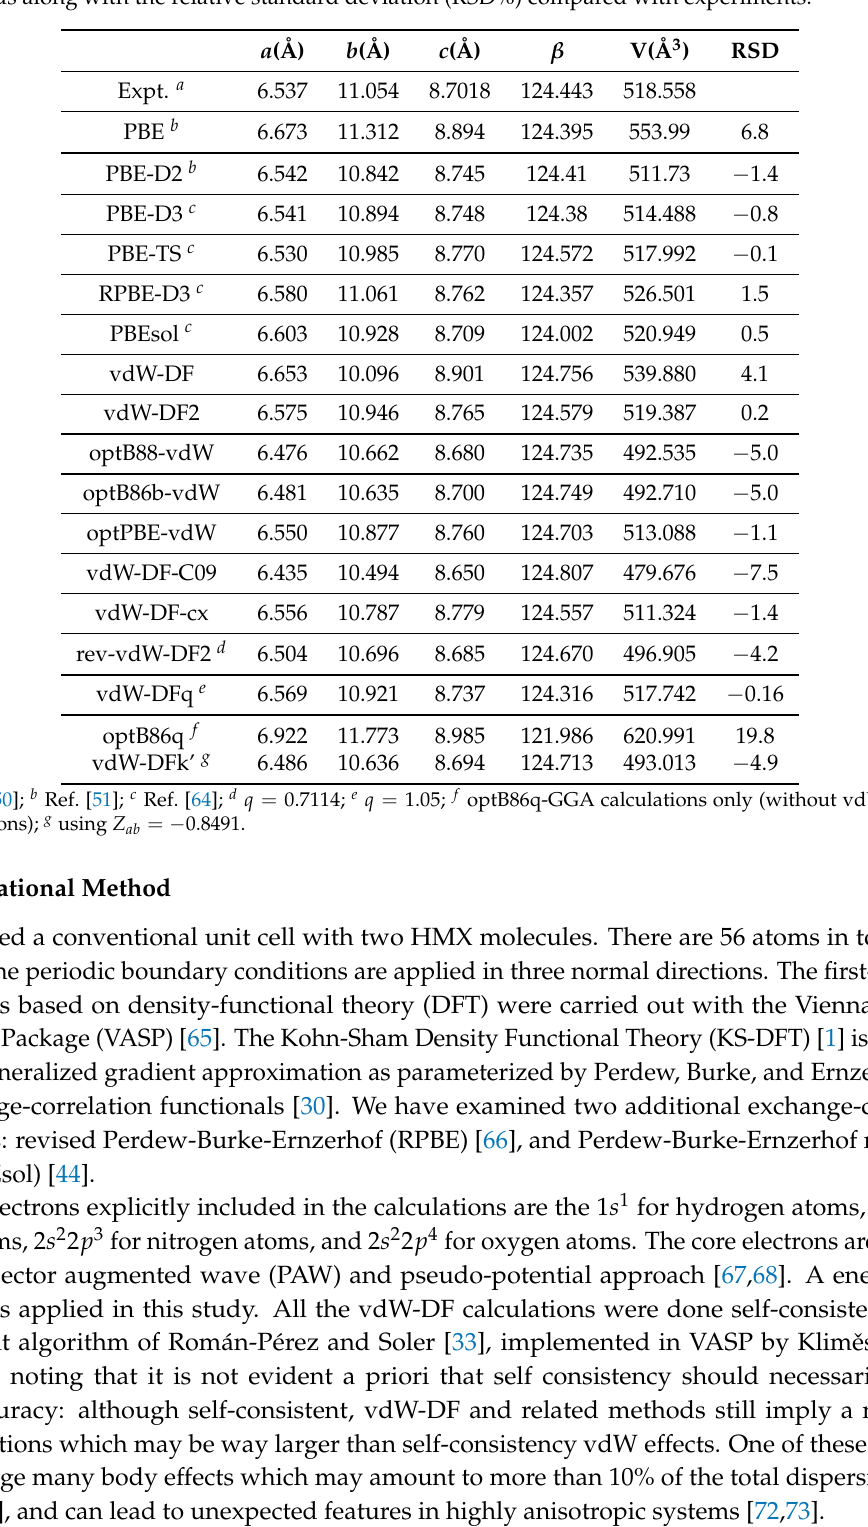
Table 1. Geometry. Lattice constants a , b , c , lattice angle β , and volume of the unit cell V from various methods along with the relative standard deviation (RSD%) compared with